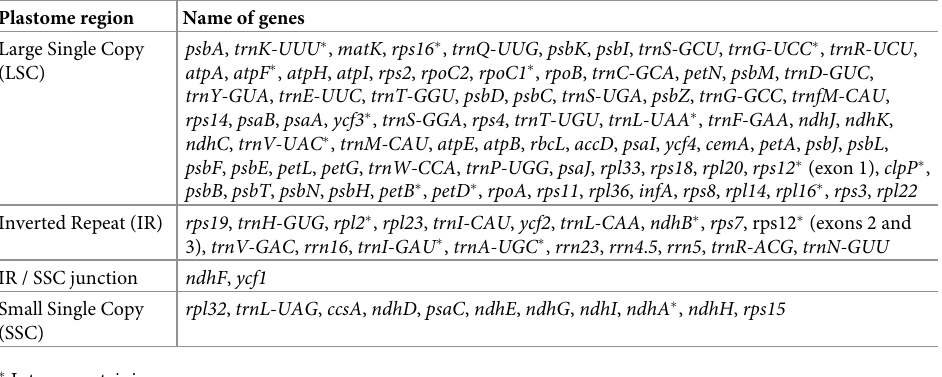
tRNA genes, 4 rRNA genes, and 7 protein-coding genes (Table 2). Among the 113 genes, 15 genes contain one intron (6 tRNA genes and 9 protein-coding genes) and 3 genes contain two introns ( clpP , ycf3 , and rps12 ; Table 2). Among intron-containing genes, 12 are located in LSC ( trnK-UUU , rps16 , trnG-UCC , atpF , rpoC1 , ycf3 , trnL-UAA , trnV-UAC , clpP , petB , petD , rpl16 ), 1 in SSC ( ndhA ), 4 in IRs ( rpl2 , ndhB , trnI-GAU , trnA-UGC ), and rps12 is a trans-splic- ing gene with the first exon located in the LSC region and the second and third exons in the IRs. Surprisingly, the cemA gene exhibited an alternative start codon, as reported in species of subtribes Attaleinae and Elaeidinae, contrasting with the Bactridinae species sequenced so far ( Astrocaryum aculeatum , Astrocaryum murumuru , and Acrocomia aculeata ). Three other genes have alternative initiation codons, rps19 (GTG), rpl2 (ACG), ndhD (ATC). Comparative analysis in tribe Cocoseae Plastomes are highly conserved (97.3% identity) within tribe Cocoseae. Species from subtribes Bactridinae and Elaeidinae have a plastome ~2 kb larger than the species from subtribe Attalei- nae. This difference in length between the subtribes is mainly in the IRs and LSC regions (Table 3). The plastomes from Cocoseae species ranged from 154.048 bp ( Butia eriospatha ) to 156.937 bp ( Elaeis guineenses ). The progressive alignment among species from tribe Cocoseae shows evidence for three Locally Collinear Blocks (LCBs) (Fig 1). These three LCBs are a result of the 4.5 kb inversion Table 3. Plastomes of tribe Cocoseae. Subtribe